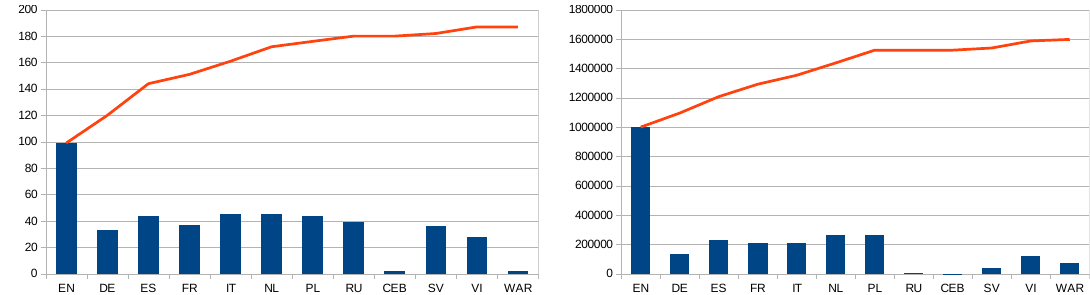
Figure 5. Number of relations ( left ) and statements ( right ) extracted at 95% precision in the top 12 languages. The bars show the number of statements that could be extracted for the given language, the line depicts the accumulated number of statements for the top N